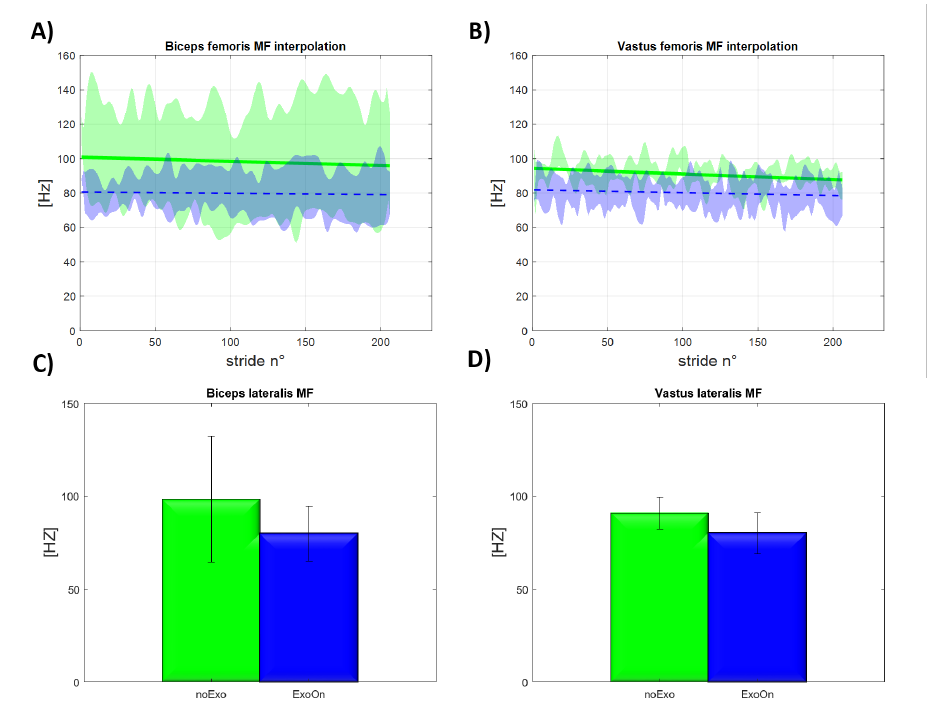
Figure 11. ( A ) Biceps femoris MF interpolation with and without XoSoft. ( B ) Vastus lateralis MF interpolation with and without XoSoft. ( C ) Biceps femoris MF mean (bars’ height), standard deviation (vertical whiskers) with and without the exoskeleton. ( D ) Vastus lateralis MF mean (bars’ height), standard deviation (vertical whiskers) with and without the exoskeleton. Both in panels ( C , D ) the horizontal line with the asterisk denotes a statistically significant